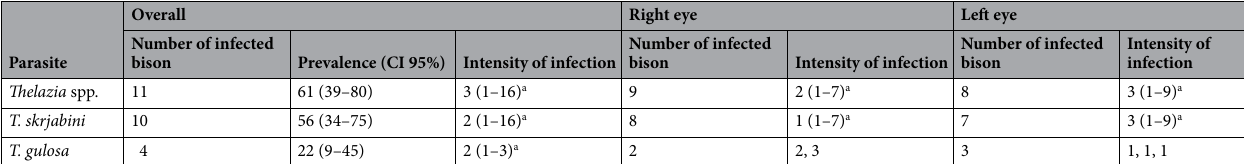
Table 1. Prevalence (percentage of infected bison) and intensity of infection (number of parasites in a single bison) with nematodes of the genus Thelazia in European bison in the Bieszczady Mountains. a Median and